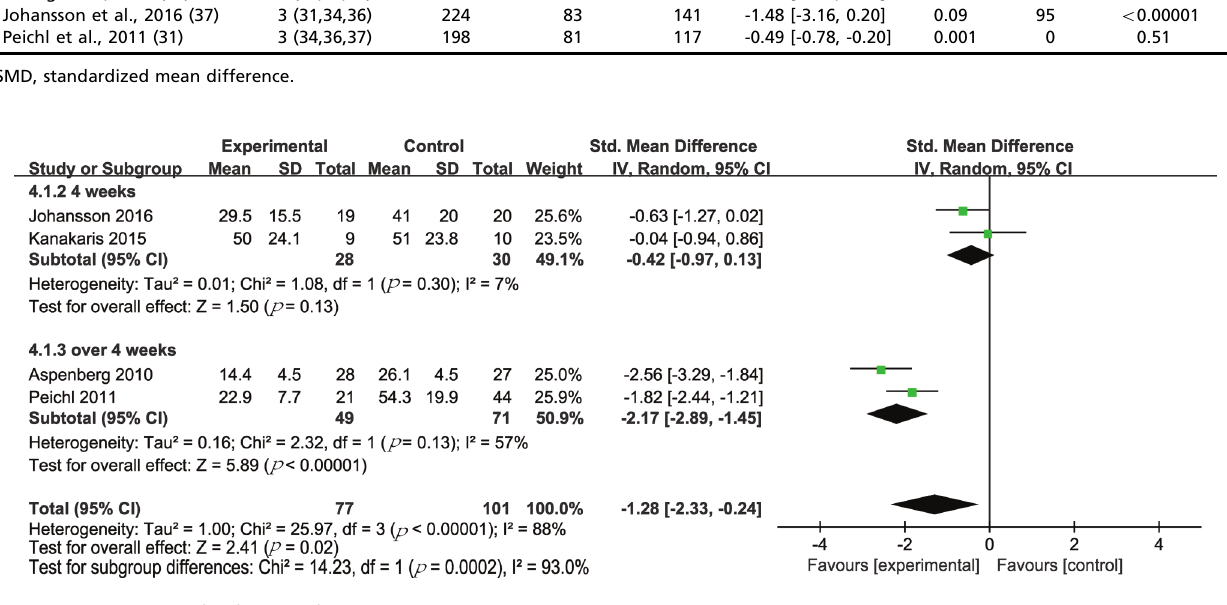
Figure 6 - Forest plot for fracture functional outcome. Table 6 - Sensitivity analyses based on various exclusion criteria for functional outcomes.